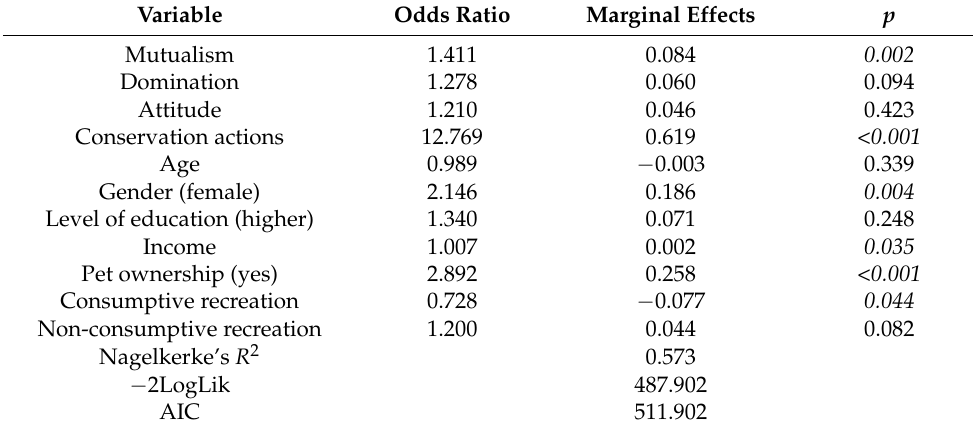
Table 5. Binary logistic regression willingness to pay model (yes/no, n = 704).